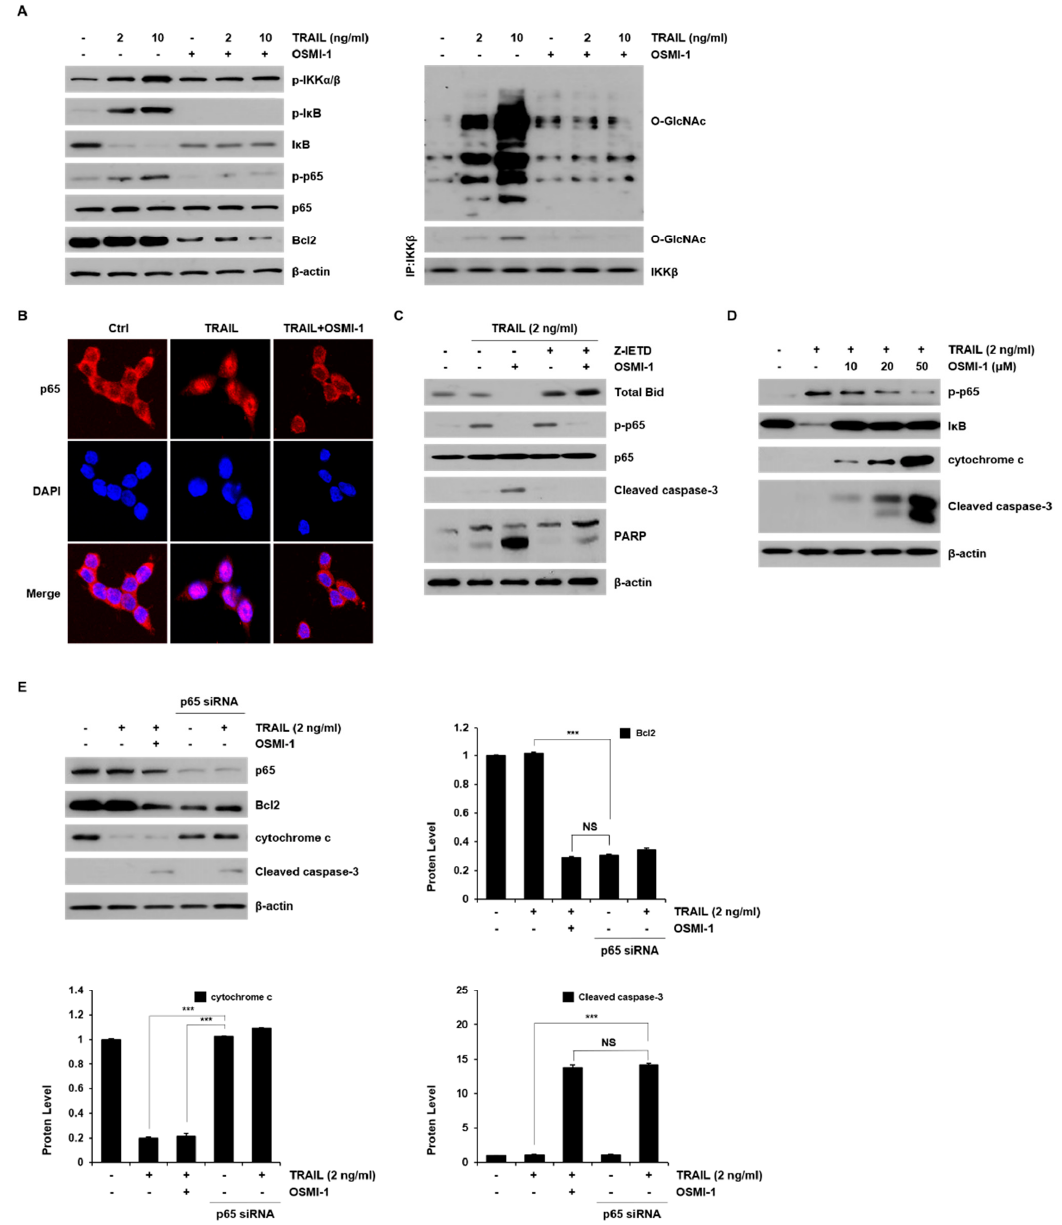
Figure 5. NF- κ B signaling was modulated by TRAIL and OSMI-1 in HCT116. ( A ) The cells were treated with TRAIL (2 and 10 ng/mL) or combination with OSMI-1 (20 µ M) for 24 h. Western blot analysis was performed to detect the levels of p-IKK α / β , p-I κ B, I κ B, p-p65, p65, Bcl2 (left panel), and O-GlcNAcylated protein (right panel). Total cell lysates were used for immunoprecipitation analysis of IKK β followed by Western blot analysis with O-GlcNAc antibody (right panel). Equal amounts of the precipitate were used to assess O-GlcNAc levels. ( B ) HCT116 cells were treated with 2 ng/mL TRAIL for 30 min in the presence or absence of 20 μ M OSMI-1. The localization of p65 was visualized using immunofluorescence analysis with anti-p65 (red) and the nucleus was stained with DAPI dye (blue). The merged image represents p65 nuclear transfer. ( C ) Cells were pretreated with or without Z-IETD-FMK for 1 h and then treated with TRAIL (2 ng/mL) for 24 h in the presence or absence of OSMI-1. Cell lysates were analyzed via western blot analysis using antibodies against Bid, p-p65, p65, cleaved caspase-3 and PARP. ( D ) Cells were treated with various concentrations of OSMI-1 (10, 20 and 50 µ M) in the presence or absence of 2 ng/mL TRAIL for 24 h. Western blot analysis was performed to determine the levels of p-p65, I κ B, cytochrome c and cleaved caspase-3. ( E ) Cells were transfected with control or p65 siRNA and then treated with TRAIL (2 ng/mL) for 24 h in the presence or absence of OSMI-1. The levels of p65, Bcl2, cytochrome c and cleaved caspase-3, were determined via western blot analysis. Data are presented as mean ± SEM, calculated from three biological replicates. *** p < 0.005; NS, not significant upon t